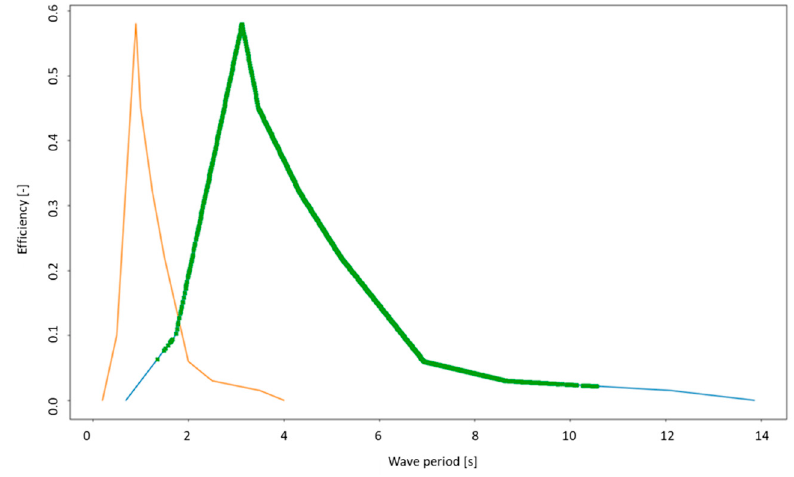
Figure 5. Efficiency of a Weptos with 3 m rotors diameter over different wave periods at location (green) and in the laboratory (yellow).